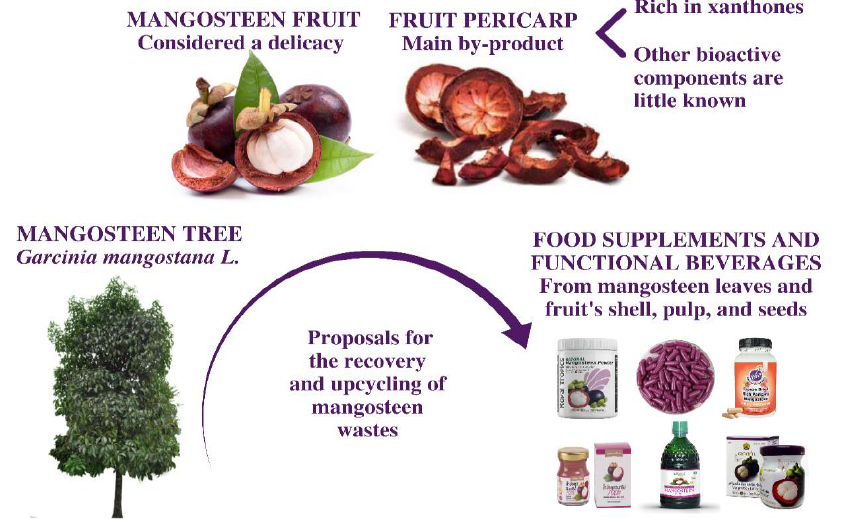
Figure 1. The Garcinia mangostana tree, its major in natura product (fruit), the major industrial by- product of its processing (fruit pericarp), and mangosteen derived-products with high added value.